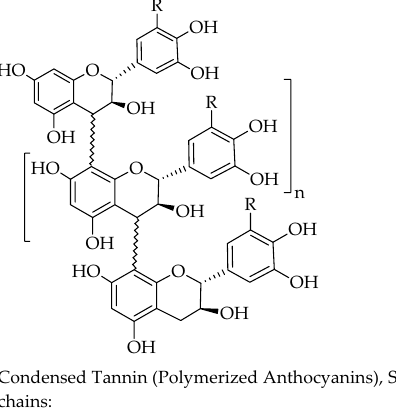
Figure 2. Chemical structure of condensed tannin made from flavonoid